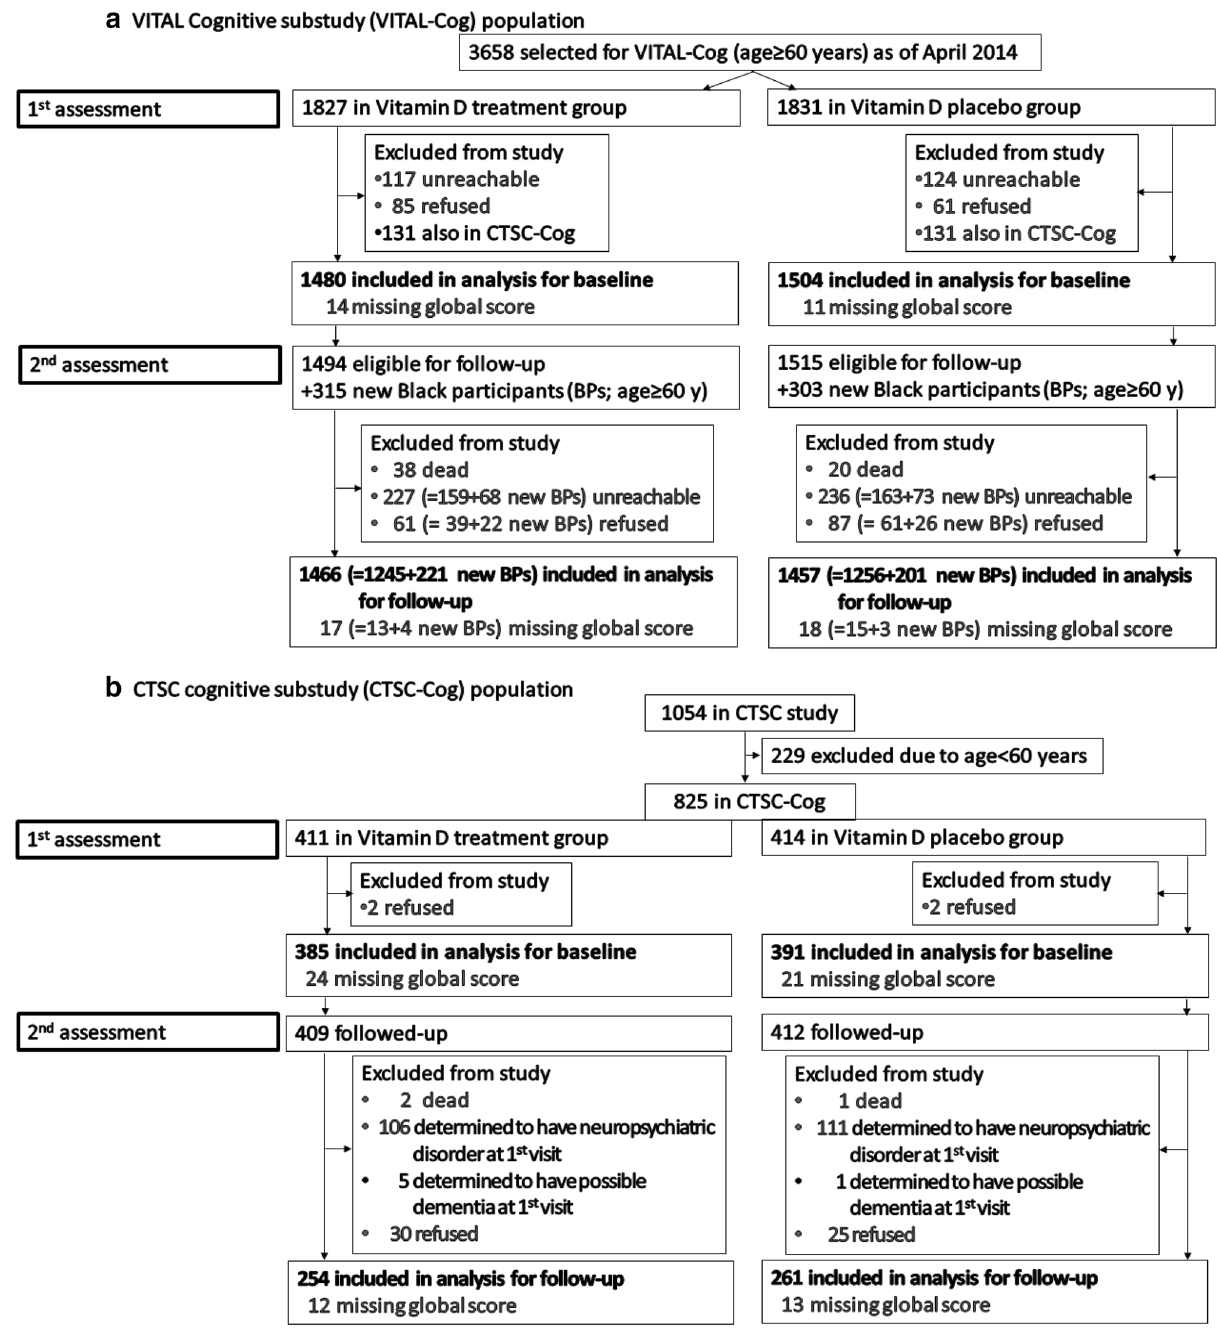
Figure 1. ( a ) Flow of Participants in the VITAL-Cog Ancillary Study to the VITAL Trial. ( b ) Flow of Participants in the subset of CTSC-Cog participants in the VITAL-DEP Ancillary Study to the VITAL